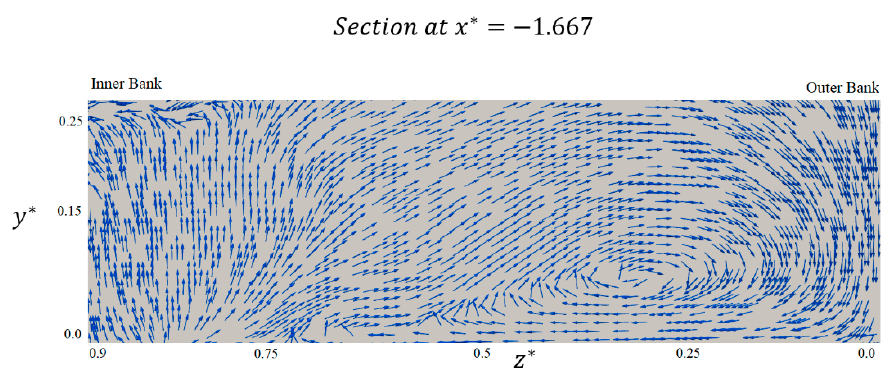
Figure 20. The vectors of velocity at section x* = − 1.667 (Realizable k- ε ).